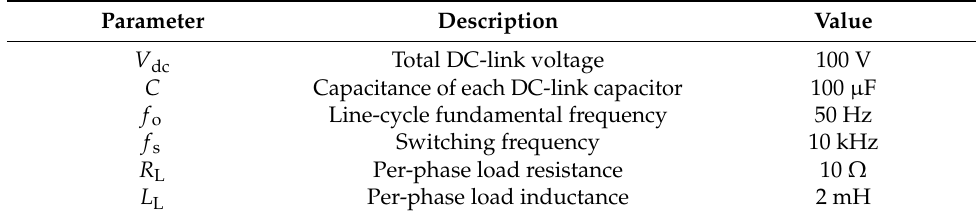
Table 2. Simulation